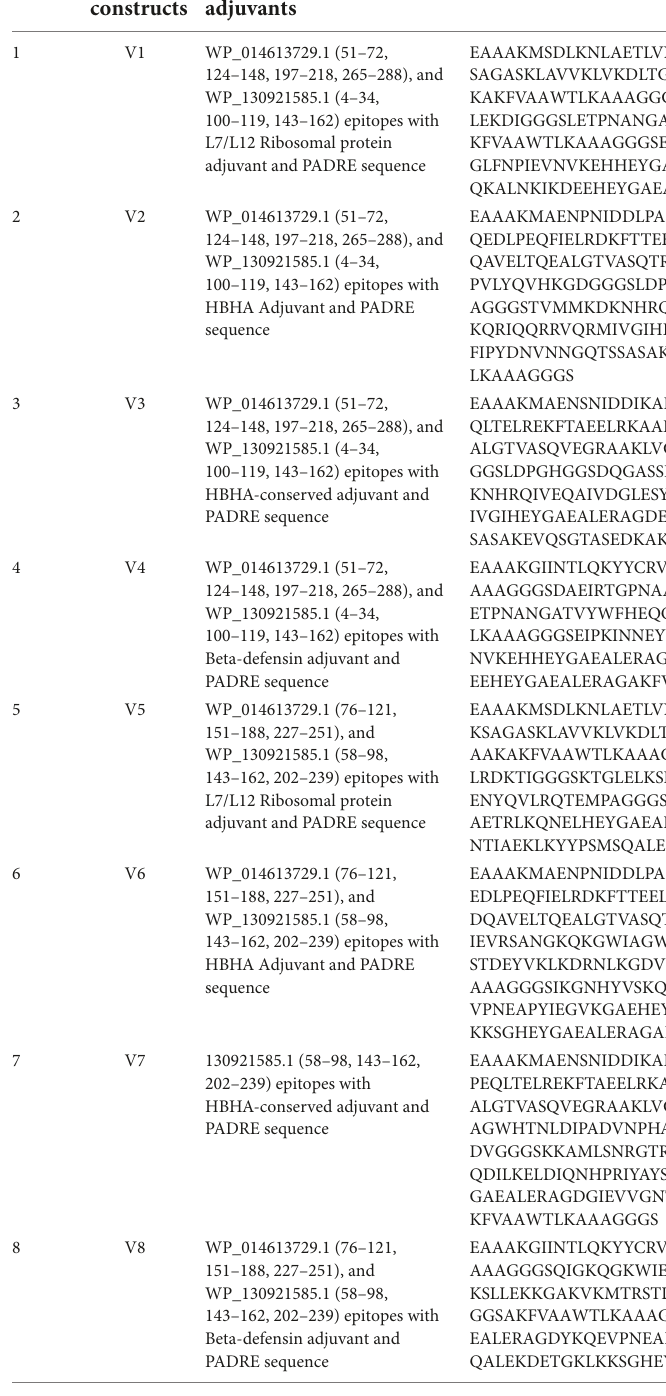
TABLE 4 Designed vaccine constructs with different adjuvant sequences.